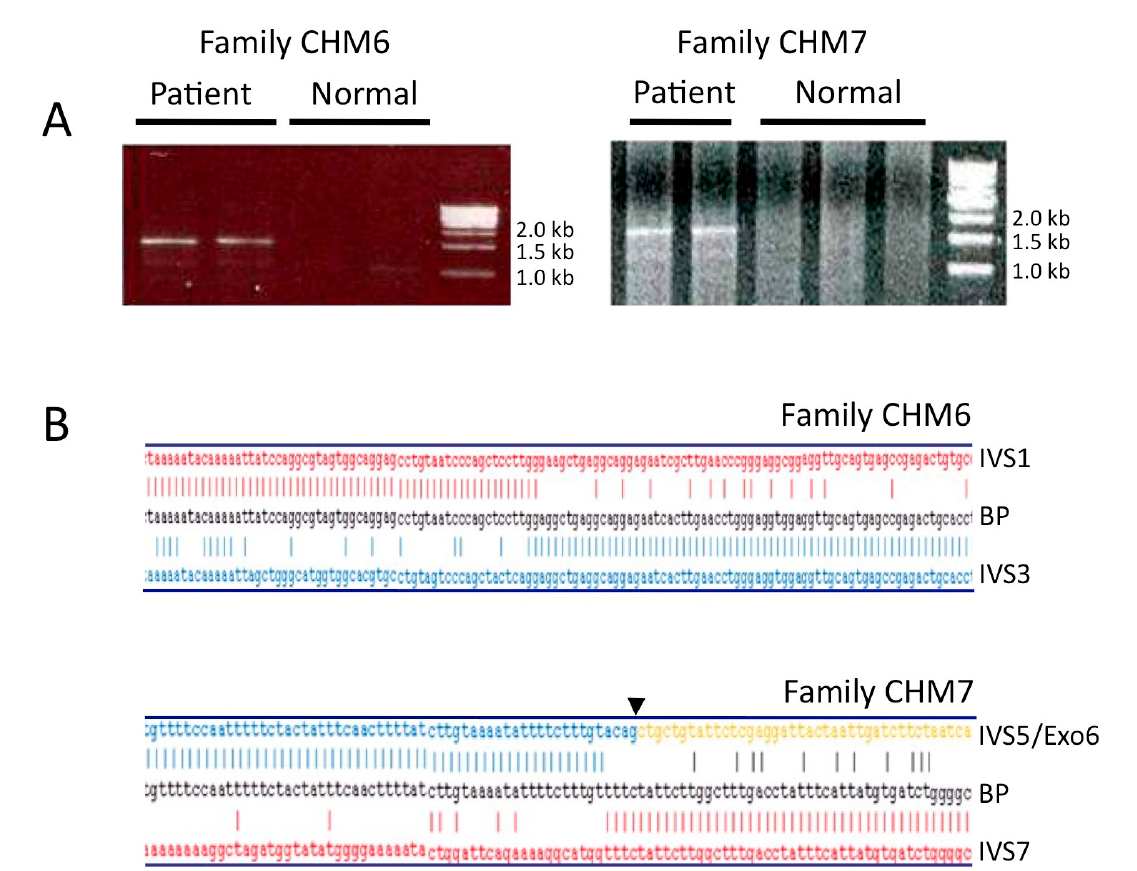
Figure 1. Mapping of intragenic deletion breakpoints in male probands of families CHM6 and CHM7. ( A ) Agarose gel electrophoresis analysis of the CHM -specific amplification products obtained by long-range PCR from probands’ genomic DNA and spanning the breakpoint junctions. Unique bands of about 1.5 and 1.7 kb were obtained in the proband of family CHM6 and CHM7, respectively; no amplification was obtained in normal controls. ( B ) Alignment of the residual CHM sequences to the reference sequence precisely maps the deletion junction, in CHM6 (top panel) and CHM7 (bottom panel) families. IVS1, intron 1 sequence; IVS3, intron 3 sequence; IVS7, intron 7 sequence; IVS5/Exo6, sequence at the intron 5/exon 6 boundary (arrow); BP, sequence of the deletion